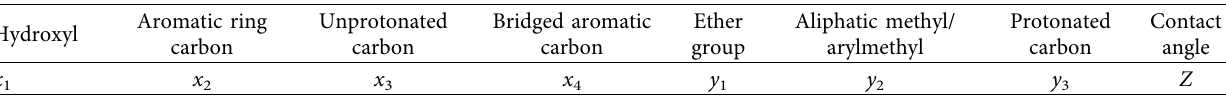
Table 11: Assignment of variables in the model of evaluating the wettability of surfactants to bituminous coal dust. Hydroxyl